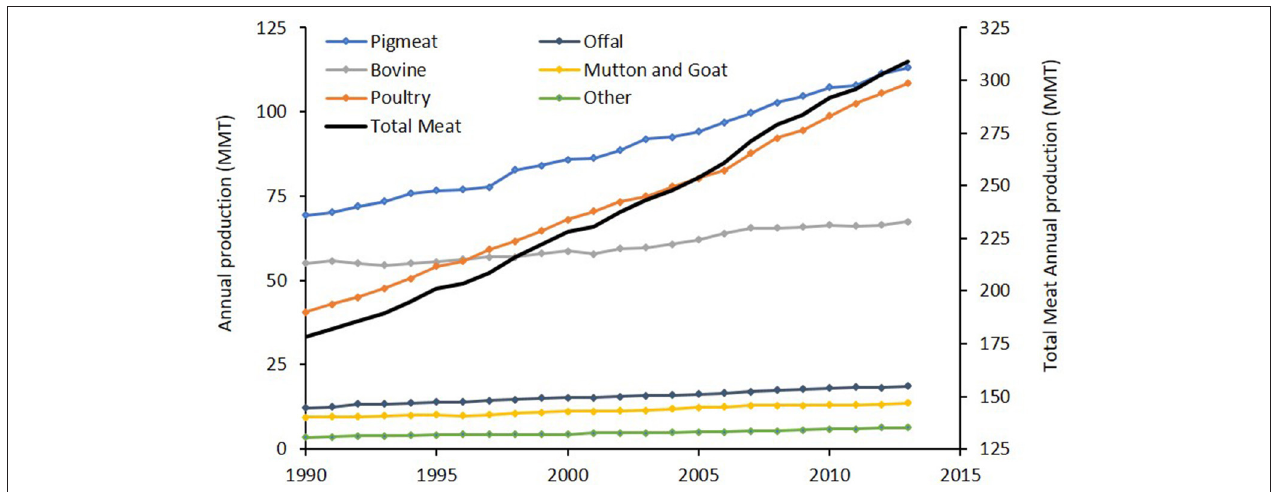
FIGURE 1 | Global production statistics for various meats and offal in million metric tons (MMT), from 1990 to 2013 (18). Total meat does not include seafood or